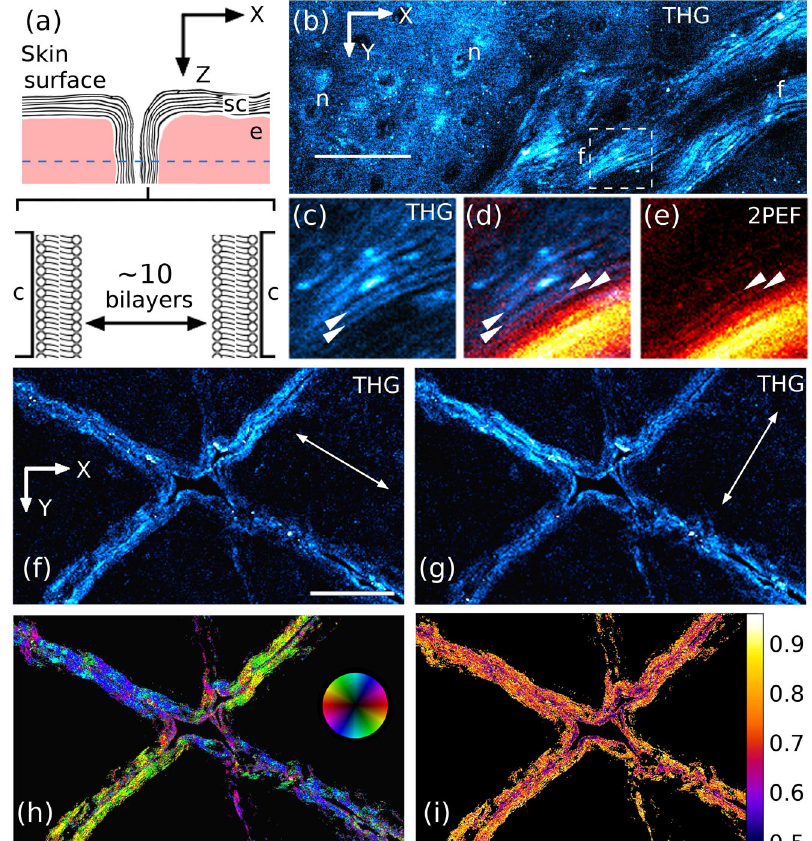
FIG. 6. Nonlinear optical imaging of samples from human skin biopsies. (a) Within the skin stratum corneum (labeled ‘‘SC’’), stacked bilayers exist between the dead corneocytes (labeled ‘‘c’’). Vertically oriented folds extending tens of microns deep into the epidermis (labeled ‘‘e’’) provide an optimal geometry for P-THG imaging (dashed blue line). (b) THG images of the skin highlight cell nuclei (labeled ‘‘n’’) as well as the folds (‘‘f’’) (scale bar 50 (cid:2) m ). (c)–(e) Subregion of the rectangular area indicated in (b). In human skin biopsies, endogenous 2PEF from the corneocytes alternating with THG signals (see white arrowheads) localizes the THG response to the intercellular lipid interfaces. (f),(g) THG images of a human skin biopsy approximately 25 (cid:2) m from the skin surface generated using two different polarizations, indicated by the straight doubleheaded arrows (scale bar 50 (cid:2) m ). Note how the folds that are oriented perpendicular to the excitation polarization appear brighter than the ones with parallel orientations. As with the MLV, the P-THG signal can be fitted to extract the stacked lipids orientation (h) and modulation (i), to gain insight into the lipid ordering within the interfaces. Even within the tissue, a strong modulation is observed exclusively from ordered phases and not from other structures. See also the movie S3 in Ref.